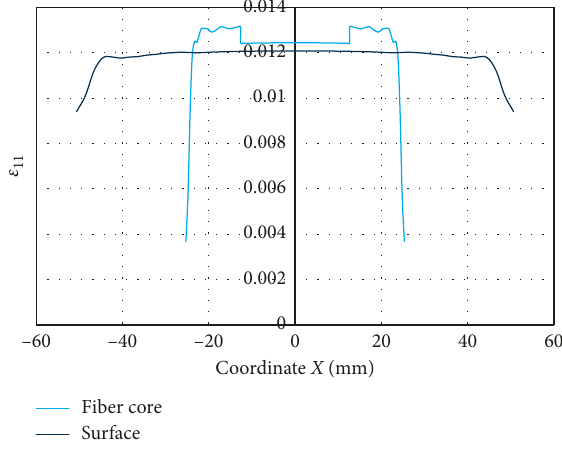
Figure 5: Strain value ε 11 in case when the fiber is attached to the surface through the adhesive layer.